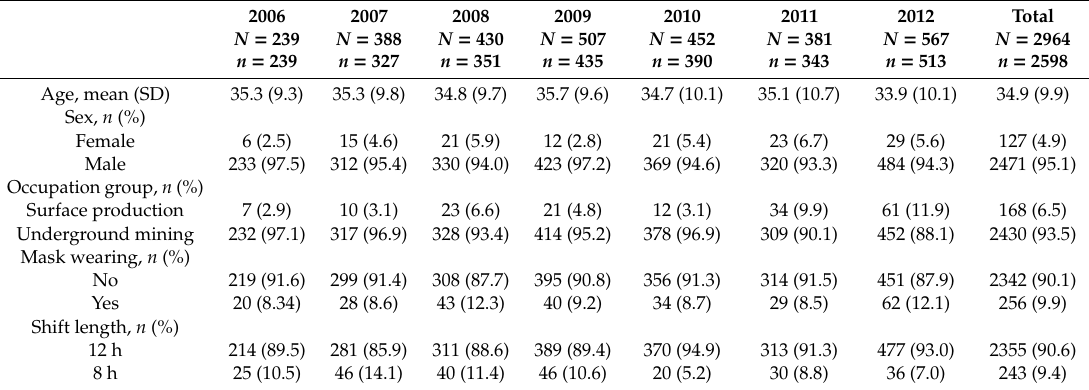
Table 1. Characteristics of the Western Australian miners,